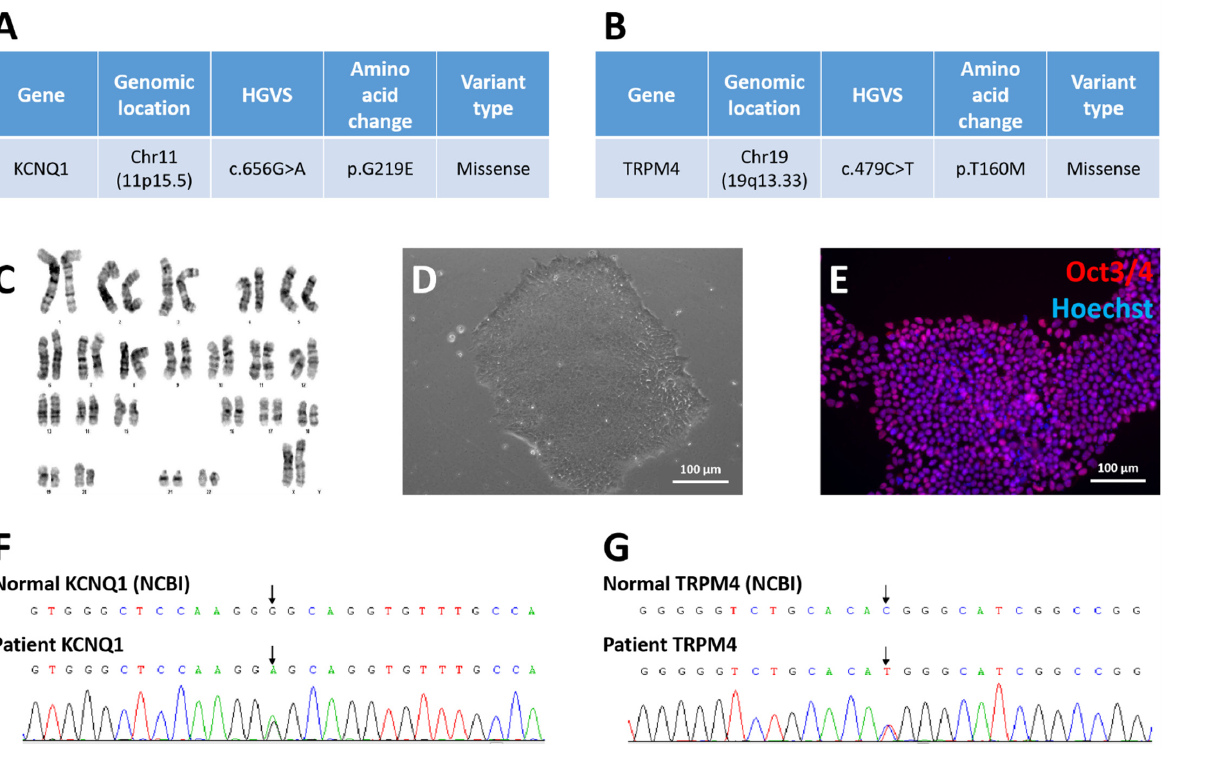
Figure 1. Derivation of LQTS-iPSC line FAHXMUi001-A from patient PBMCs. Heterozygous KCNQ1 ( A ) and TRPM4 ( B ) mutations were identified in patient PBMCs through WES. iPSCs derived from patient PBMCs demonstrated normal 46 XX karyotype ( C ), typical colony morphology of pluripotent stem cells ( D ) and were positive for pluripotent stem cell marker Oct3/4 ( E ). By us- ing WES, heterozygous KCNQ1 ( F ) and TRPM4 ( G ) mutations were identified in FAHXMUi001-A cells.